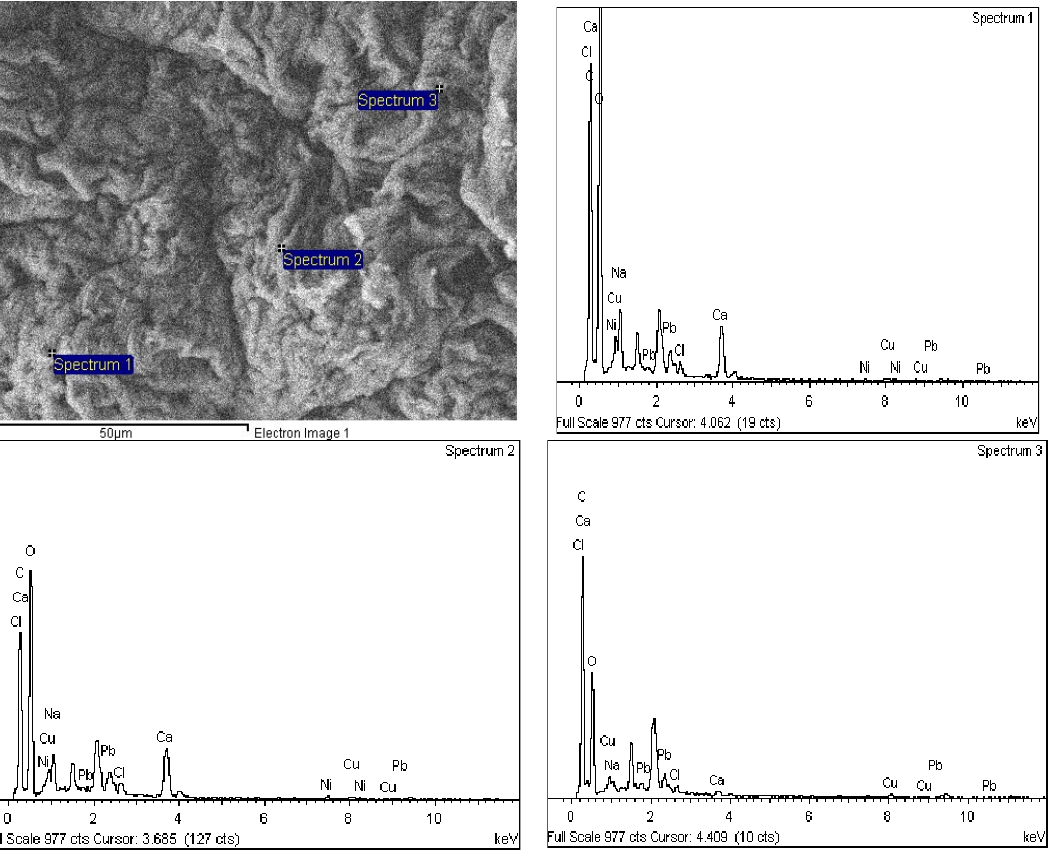
Figure 16 . EDX spectra of SA −β− CD/CNTs hydrogel after Ni(II) adsorption . Figure 16. EDX spectra of SA − β − CD/CNTs hydrogel after Ni(II)